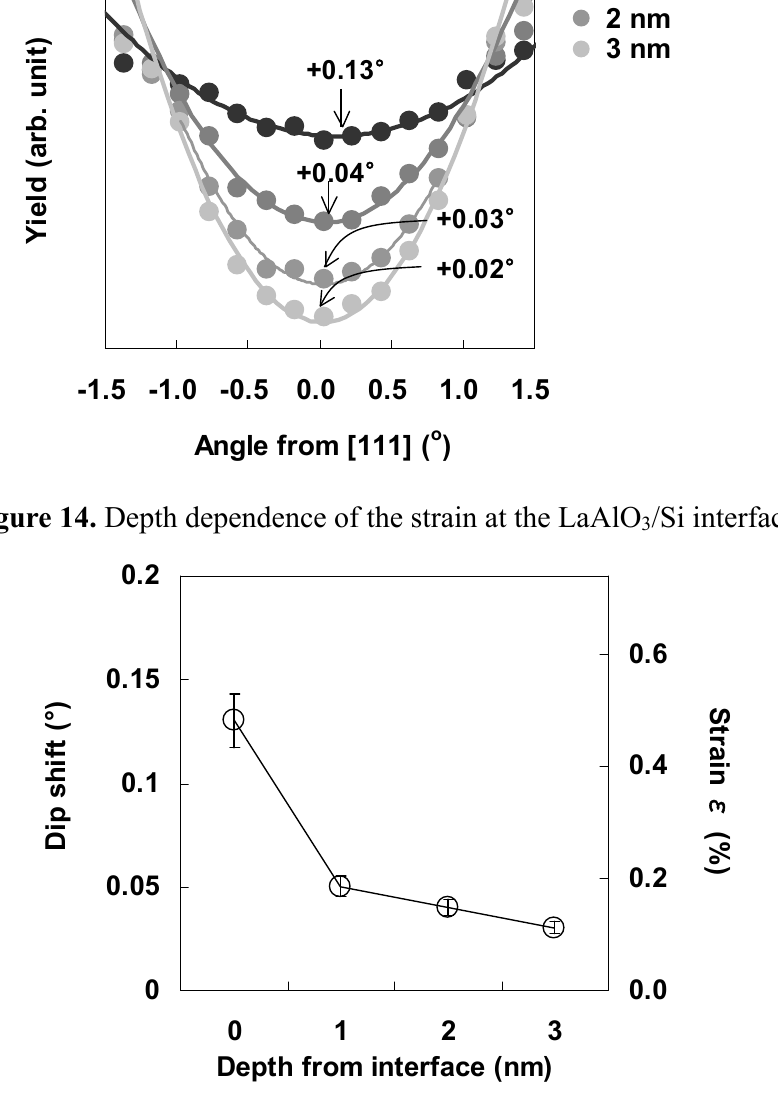
Figure 13. Scattering yield from Si at various depths from the interface as a function of the incident angle relative to the [111] direction for the as-deposited specimen.